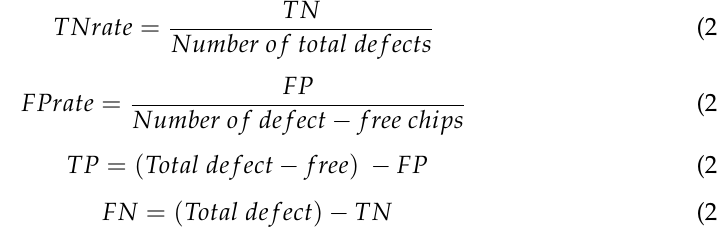
Table 1. Inspection quality